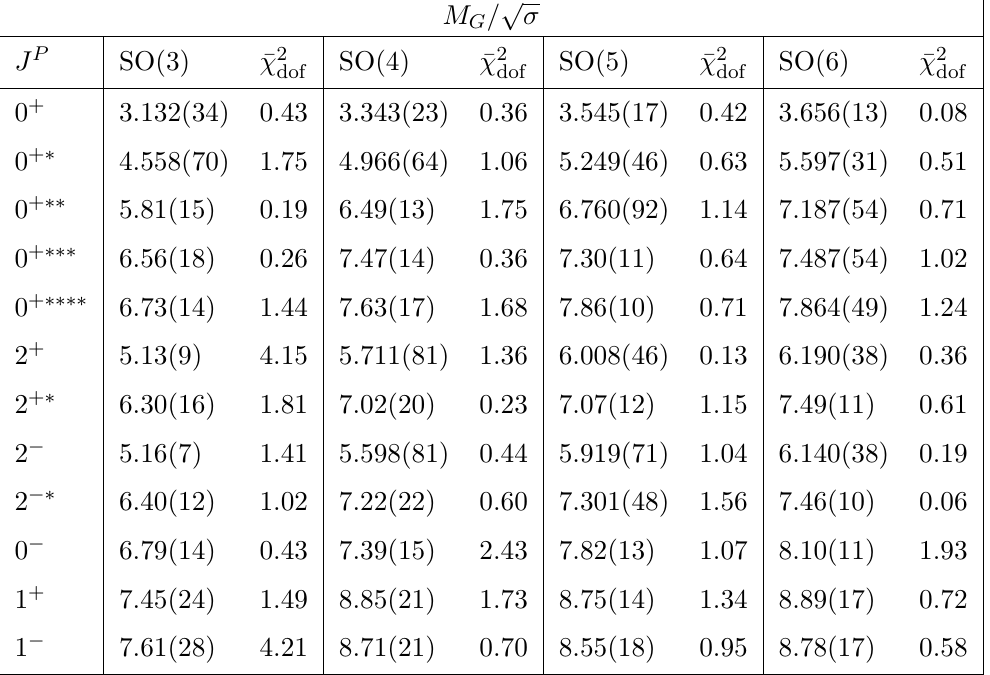
p (cid:27) , for SO(3), SO(4), SO(5),